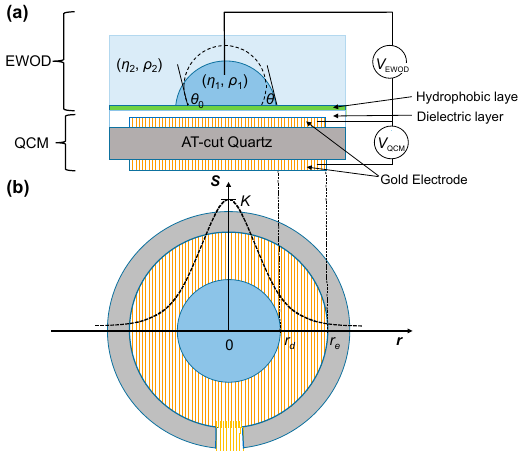
Figure 1. Schematic illustration of the experimental setup in which electrowetting-on-dielectric (EWOD) dielectric and hydrophobic layers were deposited on a quartz-crystal microbalance (QCM) to generate a variation of contact angle θ . ( a ) Cross-sectional view. ( b ) Top